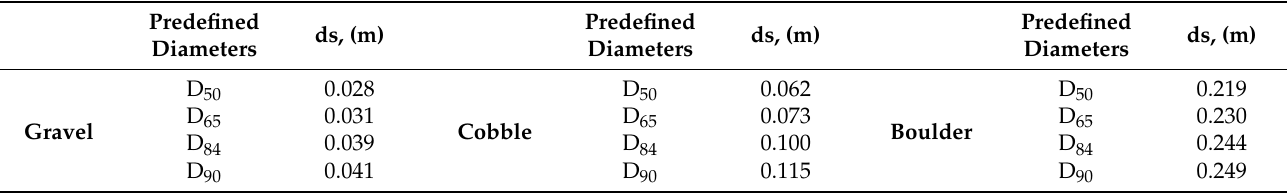
Table 4. Estimated predefined diameters for each river bed class.